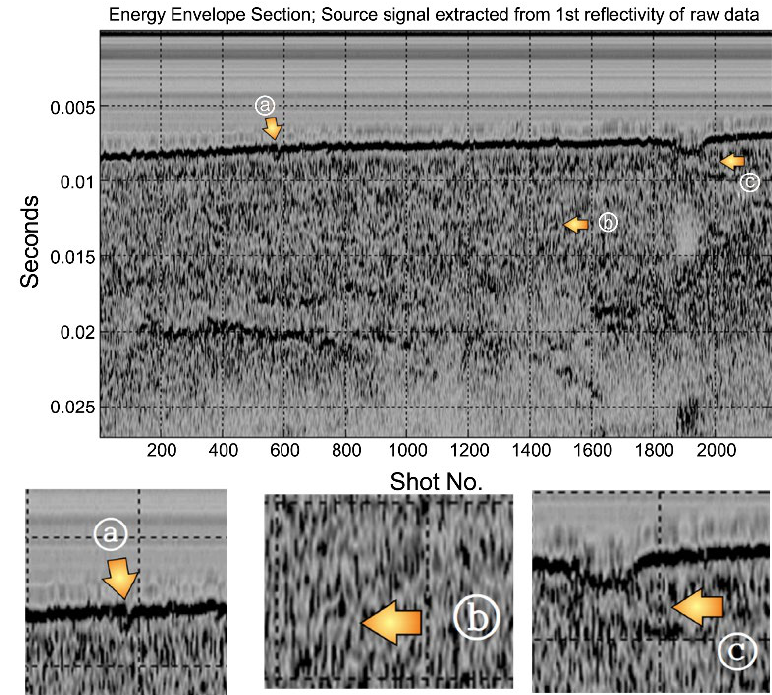
Figure 14. Chirp sub-bottom profiler (SBP) envelope section generated with Source III. As for Location (b), Figure 12 shows an abnormal signal, which is not visible in Figures 13 and 14. Location (c) is a reflection signal from a buried object near the